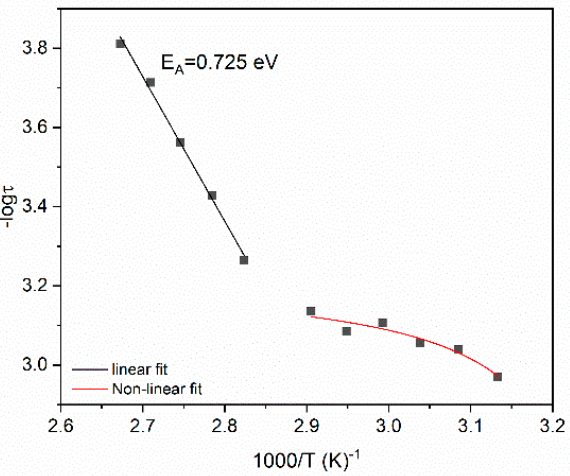
Figure 11. Relaxation time as a function of reciprocal temperature for the IDE process in the 40 phr SrFe 12 O 19 /10 phr BaTiO 3 /epoxy nanocomposite.